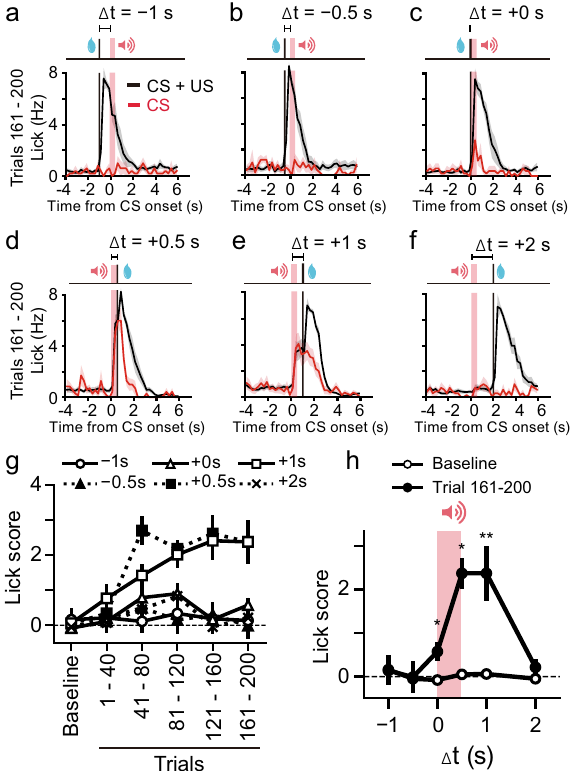
Figure 2. Conditioning with various delays of the US. ( a – f ) Averaged PSTHs of the licking responses with delays of − 1 s ( a , n = 5 mice), − 0.5 s ( b , n = 5 mice), + 0 s ( c , n = 5 mice), + 0.5 s ( d , n = 7 mice), + 1 s ( e , n = 11 mice), or + 2 s ( f , n = 7 mice) during trials 161–200. The plot in ( d ) is the same as that at the bottom of Fig. 1f. Red shades indicate the period of CS presentation. ( g ) Peak lick scores plotted against time. Each symbol represents the delay in the US relative to the CS. ( h ) Time windows for US presentation leading to conditioning. The averaged lick scores in the baseline session (white circle) and CS-only trials included during conditioning trials 161–200 (black circle) were plotted against delays between the CS and US. Wilcoxon signed-rank test. * P < 0.05, ** P <